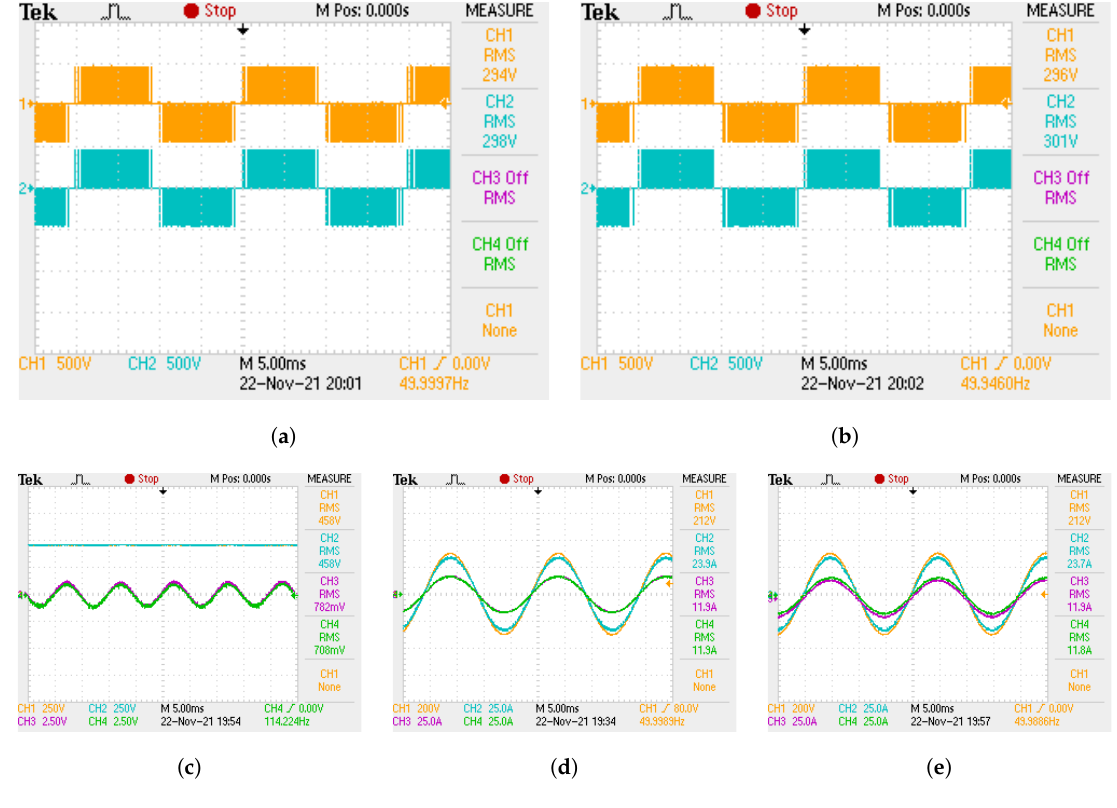
Figure 21. 2-modules IPOP configuration experimental results: ( a ) Primary side switching voltages, ( b ) Secondary side switching voltages, ( c ) DC-links voltages, ( d ) Primary side grid voltage and currents, ( e ) Secondary side grid voltage and